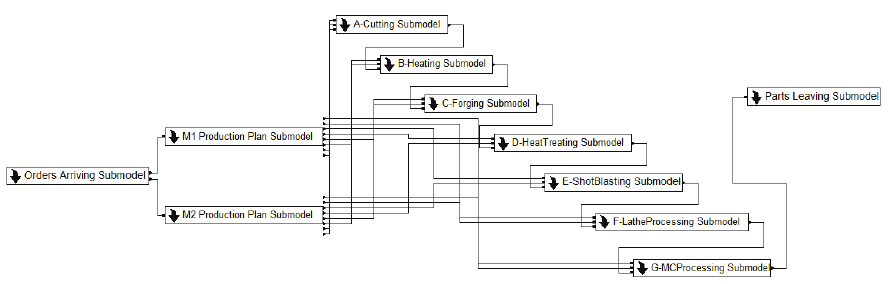
Fig. 6. AS-IS simulation model.